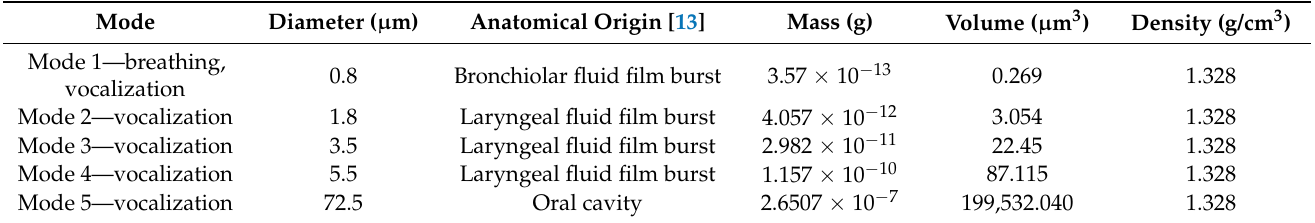
Table 2. Ambient air respiratory aerosol particle characteristics used for in silico deposition